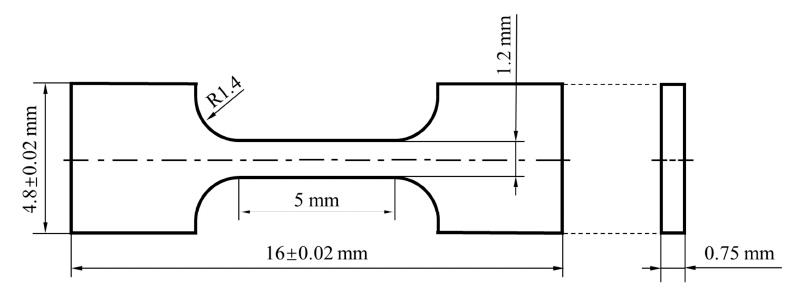
Figure 3. Shape and dimensions of the miniature tensile